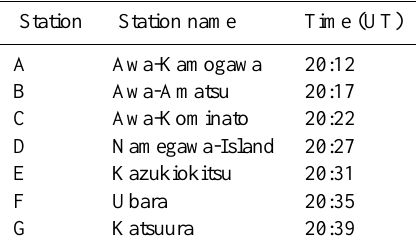
Table 2. Railway stations and the timetable for the first